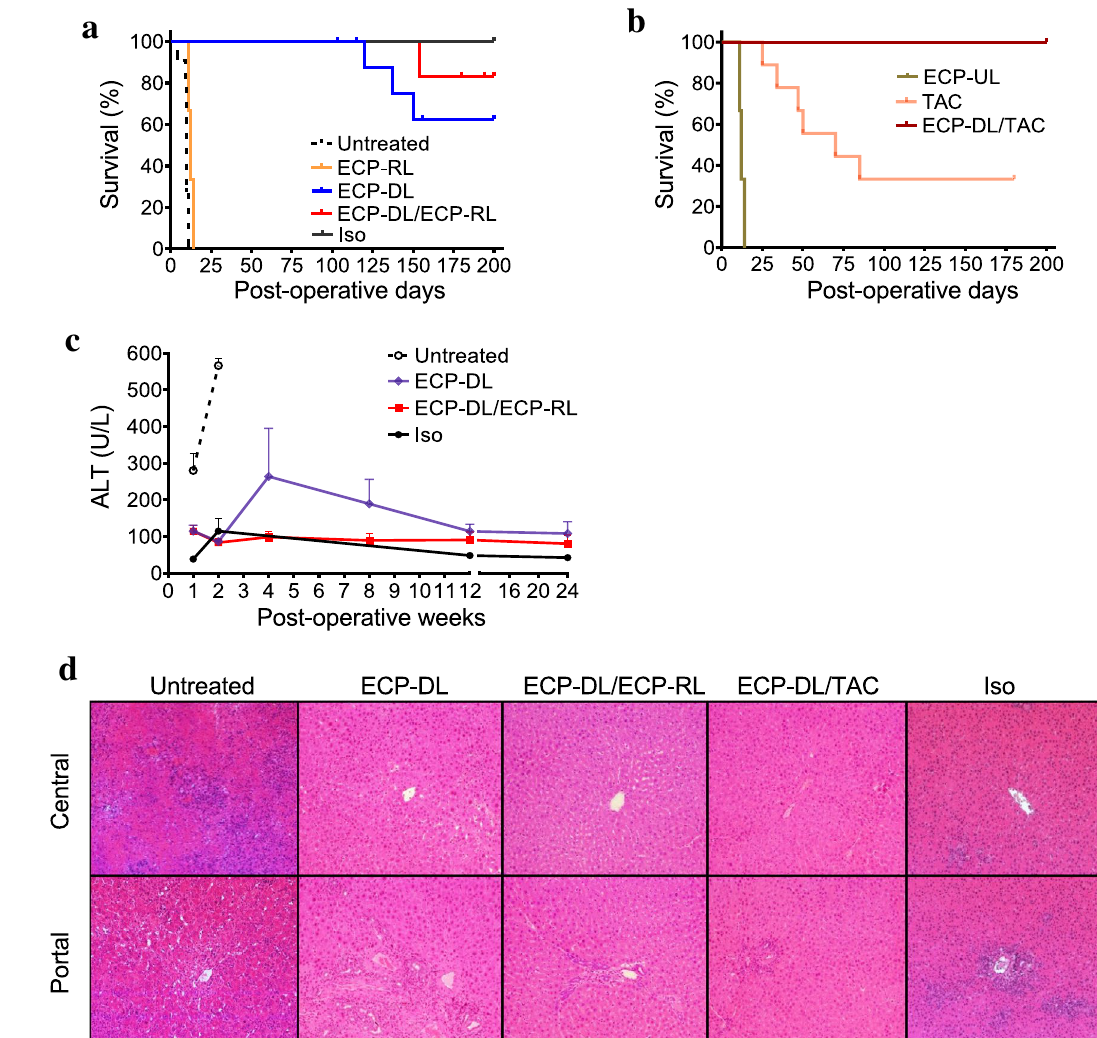
Figure 7. A single infusion of ECP-DL significantly prolonged the survival of liver allografts, while maintaining normal liver function and histologic appearance. Liver transplants from ACI rats into Lewis rats. ( a and b ) Kaplan Meier survival curves showing ECP-DL significantly prolonged the survival of liver transplant recipients and was synergistic with ECP-RL or a short course treatment with TAC. Untreated, n = 11; ECP-RL, n = 3; ECP-DL, n = 10; ECP-DL/ECP-RL, n = 6; Iso, n = 3; ECP-UL, n = 3; TAC, n = 9; ECP-DL/TAC, n = 4. ECP-DL versus Untreated or ECP-RL, **** P < 0.0001; ECP-DL/TAC versus TAC, * P < 0.05, by Log-rank test. ( c ) ALT testing revealed overall preservation of liver function in ECP-DL and ECP-DL/RL recipients despite an initial rise at week 4 in the ECP-DL group. Mean ± SEM; n = 3–6 for each timepoint. Untreated versus ECP-DL or ECP-DL/ECP-RL, ** P < 0.0001 at the first post-operative week, **** P < 0.0001 at the second post-operative week by the unpaired t -test. ( d ) Hematoxylin and eosin stains of liver grafts at the time of sacrifice reveal that liver tissue from untreated animals have a significant amount of infiltrative inflammatory cells; liver tissue retrieved from ECP-DL and ECP-DL/ECP-RL animals had near-normal histology like isograft